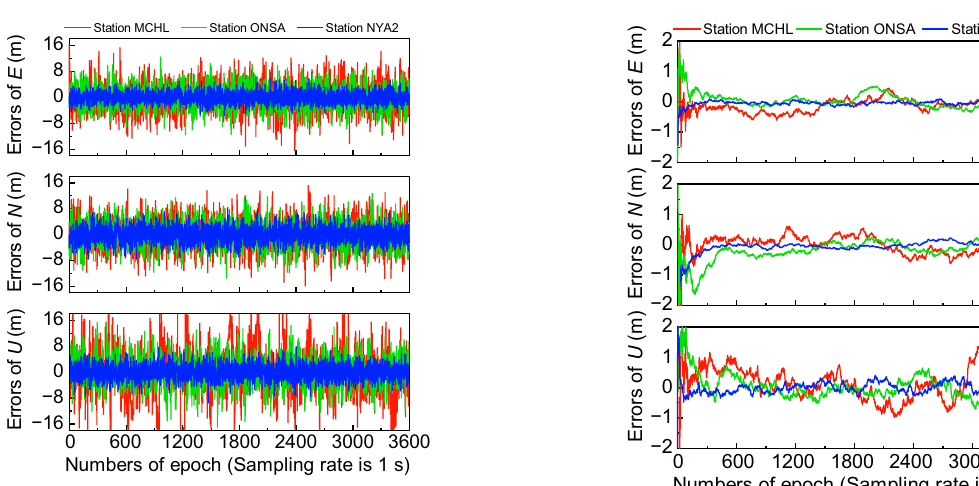
Fig. 12 Results of kinematic Doppler positioning solutions in the east (E), north (N) and up (U) directions, respectively, at station MCHL, ONSA and NYA2 for scheme